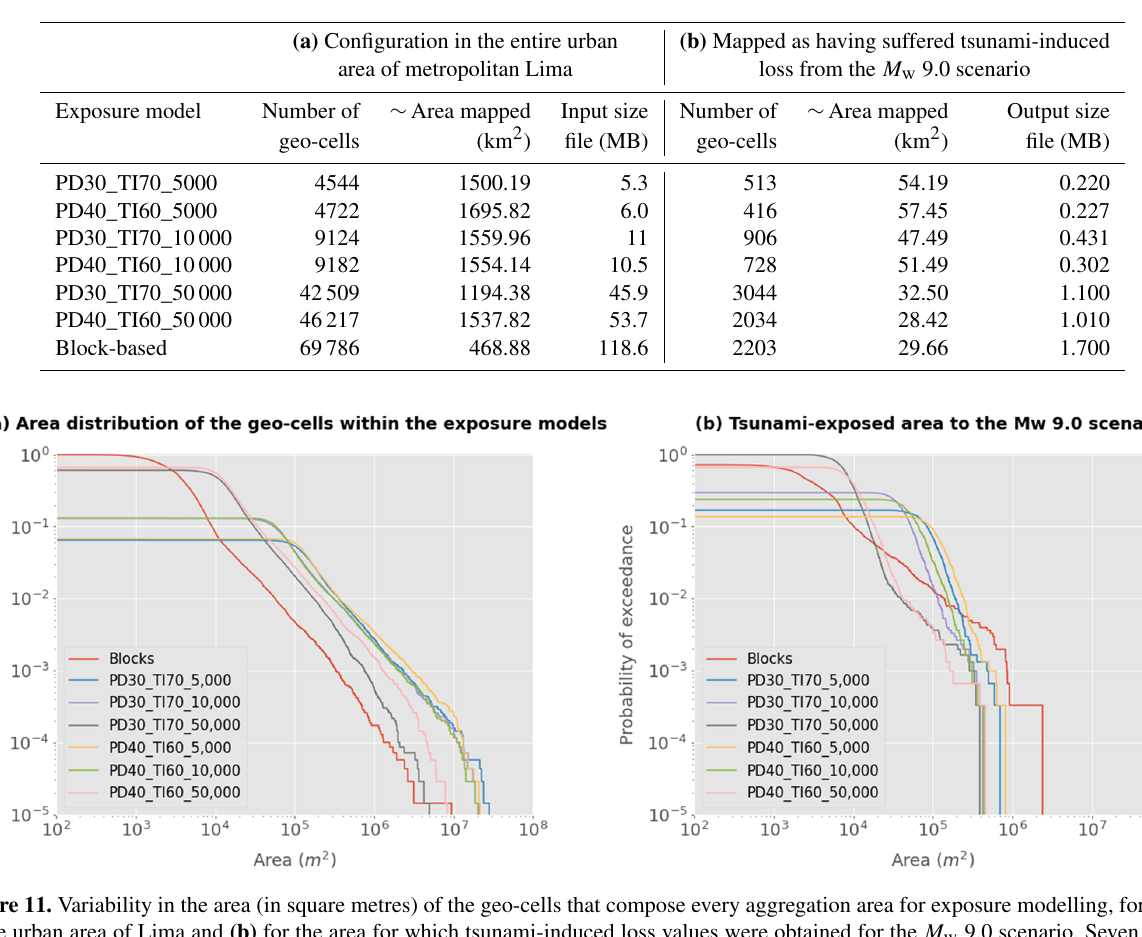
Table 2. Variability of area (km 2 ) and file size (MB) across the exposure models proposed for (a) the entire urban area of metropolitan Lima and (b) for the area exposed to the tsunami from the M w 9.0 scenario event. Only geo-cells with an urban land use are considered.